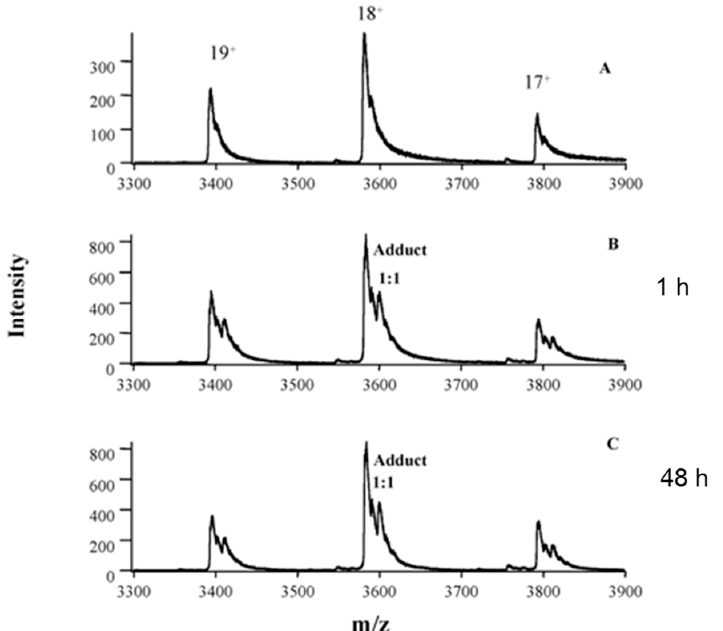
Figure 3. Analysis of erythrocyte samples from patient 1, who was undergoing oxaliplatin treatment, showing in vivo formation of intact Hb–oxaliplatin adducts. Spectra were obtained from erythrocytes of a healthy volunteer ( A ) and erythrocytes from blood samples of patient 1 collected at 1 ( B ) and 48 h ( C ) after the first infusion of oxaliplatin. Reprinted with permission from [43]. Copyright American Association for Clinical Chemistry 2005.